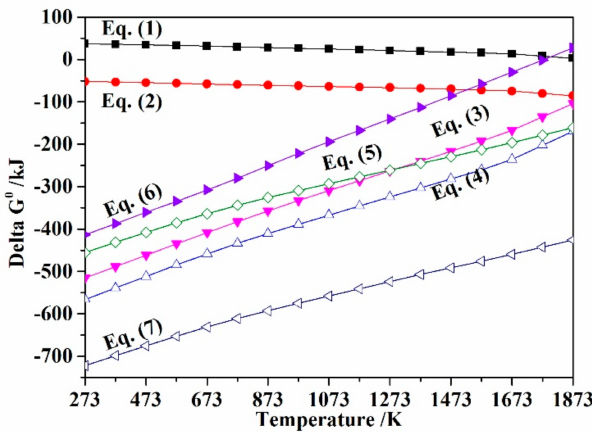
Figure 2. Relationship between ∆ G 0 and